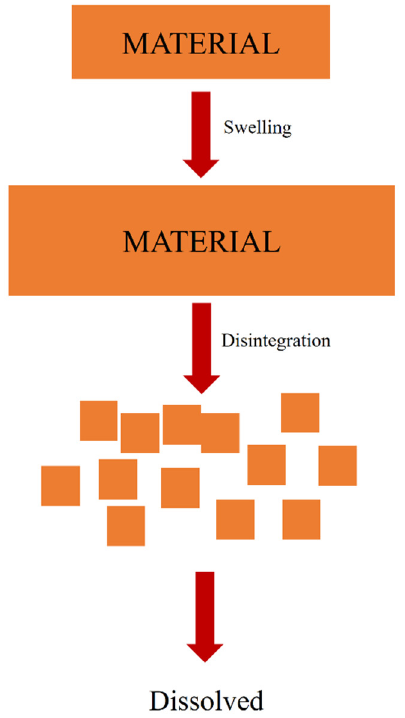
Figure 5. Disintegration process mechanism.